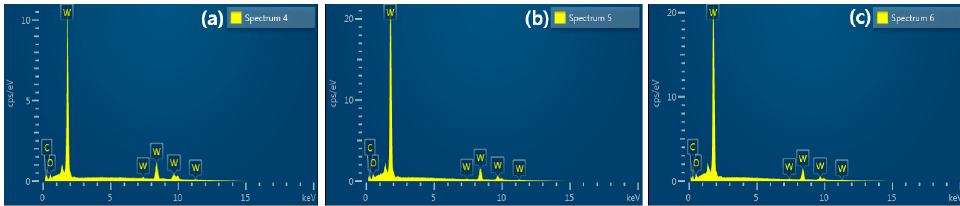
Figure 3. E nergy-dispersive X-ray spectroscopy component analysis of tungsten plate. ( a ) Hot-rolling process for the 0.3 mm plate, ( b ) hot-rolling process for the 0.1 mm plate, ( c ) cold-rolling process for the 0.1 mm plate.